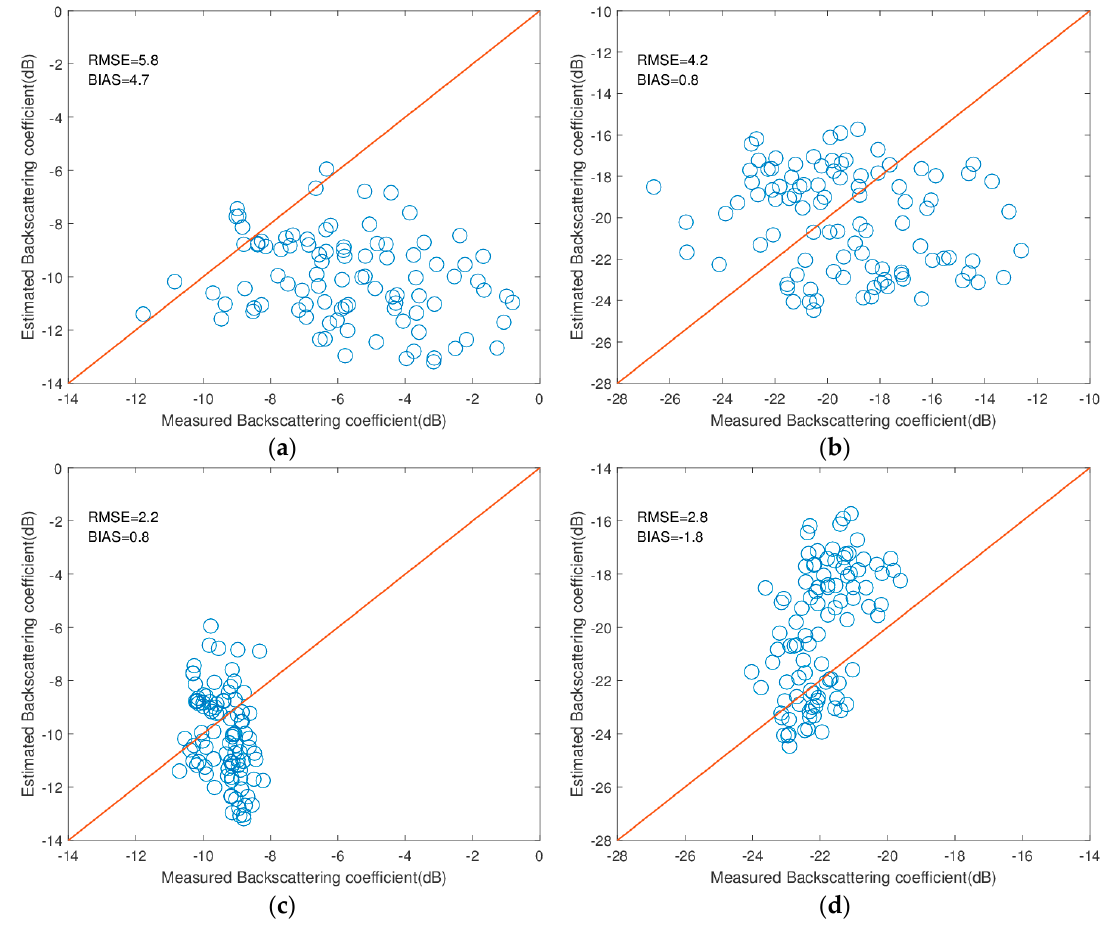
Figure 2. Backscattering coefficients calculated from the integral equation model (IEM) and calibrated integral equation model (CIEM) vs. the observations measured by synthetic aperture radar (SAR) at the C-band: ( a ) VV polarization, IEM; ( b ) VH polarization, IEM; ( c ) VV polarization, CIEM; ( d ) VH polarization, CIEM.